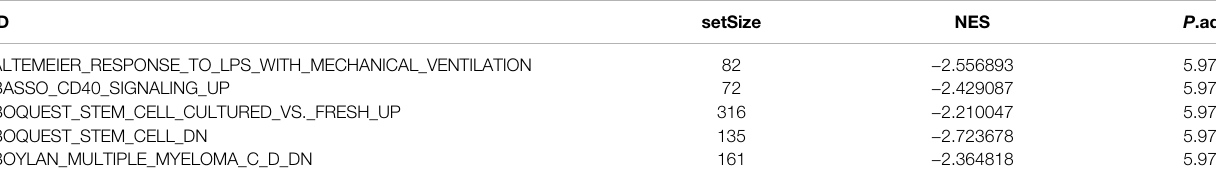
TABLE 4 | GSEA enrichment of immune-related clusters. ID setSize